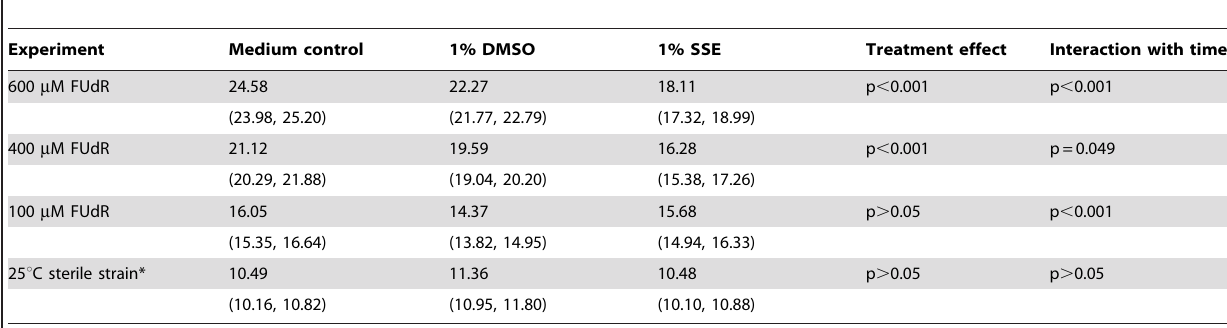
Table 3. Median Lifespan estimates for 0 to 600 m M FUdR in the presence of the treatments 1% SSE, 1% DMSO or medium alone.